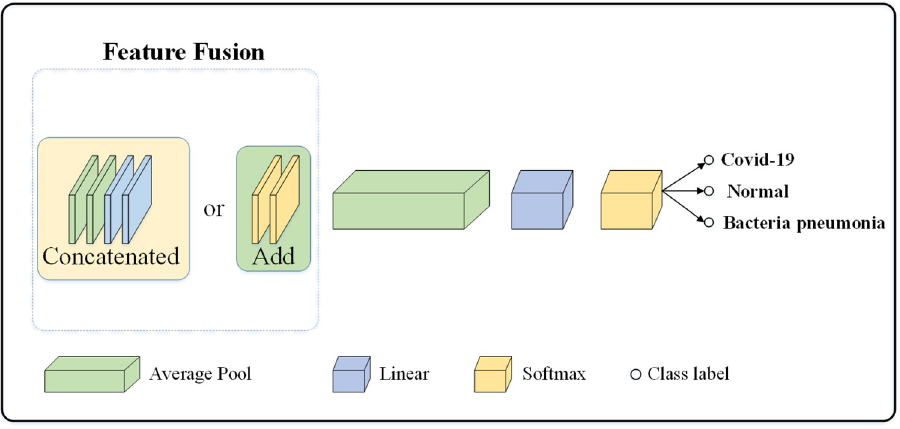
Fig 7. Feature classification